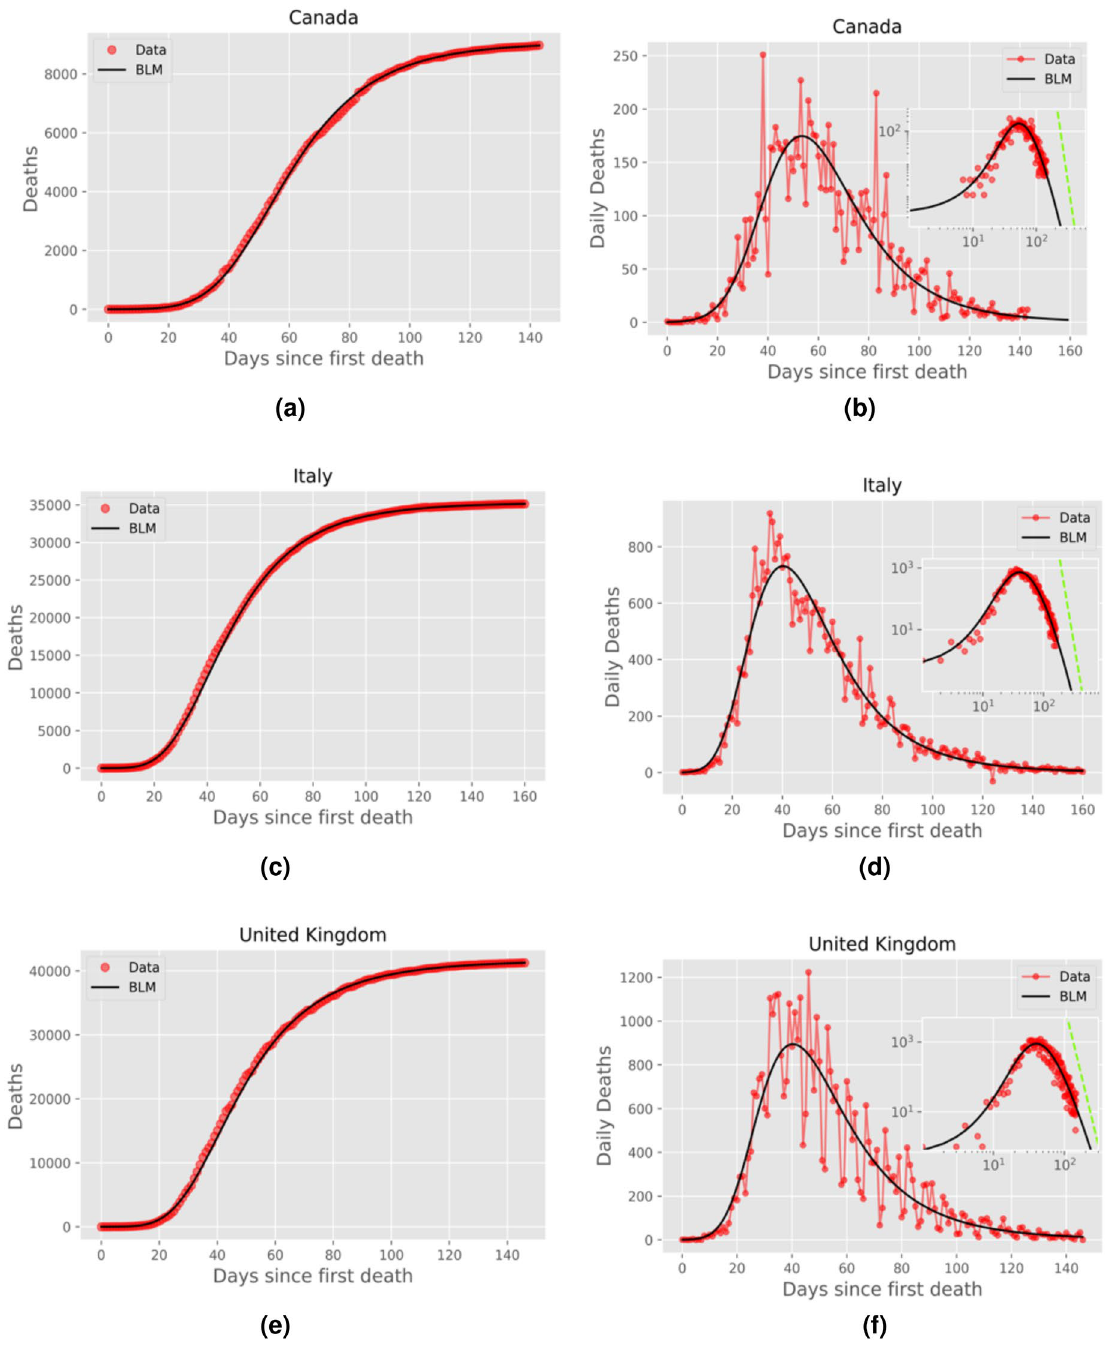
Figure 2. Left panels: Cumulative number of deaths (red circles) attributed to COVID-19 up to July 31, 2020, for ( a ) Canada, ( c ) Italy, and ( e ) United Kingdom; the solid black curves are the best fits by the beta logistic model, with the corresponding parameters given in Table 1. Right panels: Daily number of deaths for the same countries, where the empirical data are indicated by red circles and the solid black curve represent the time derivative of the respective theoretical curve in the left panels; the insets show the same graphs as in the main plots, only in log-log scale, where the green straight lines correspond to the power-law asymptotic behaviour predicted by